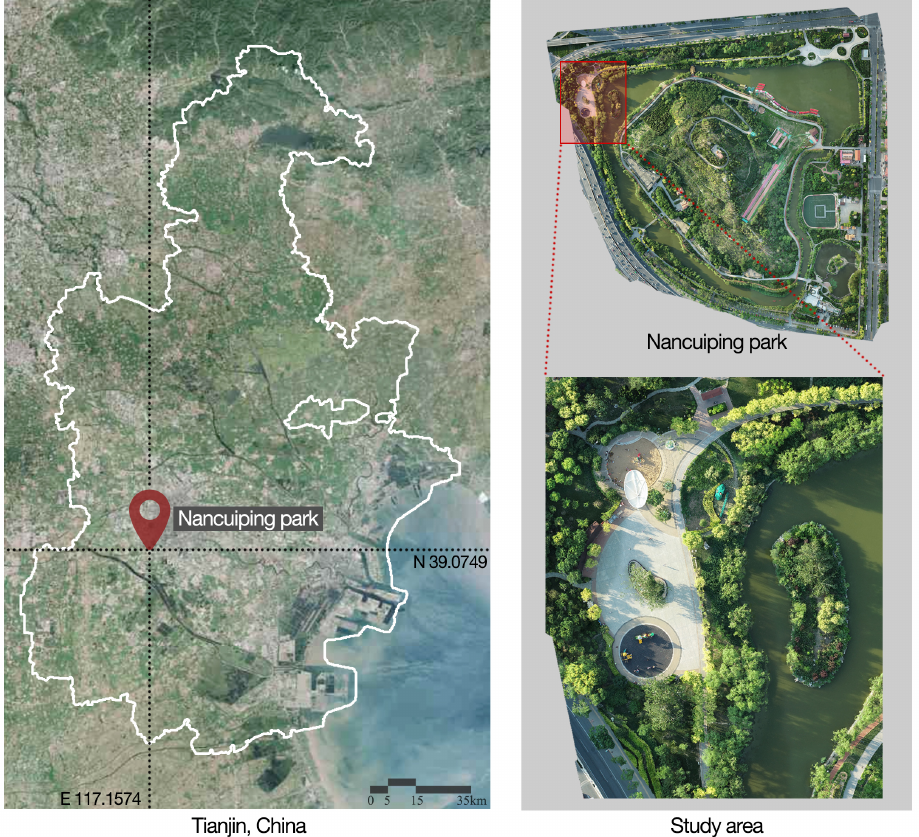
Figure 1. Nancuiping Park and the study area. Orthophoto maps ( left ) were taken using UAV photogrammetry. Source of the satellite image ( right ) taken from Google